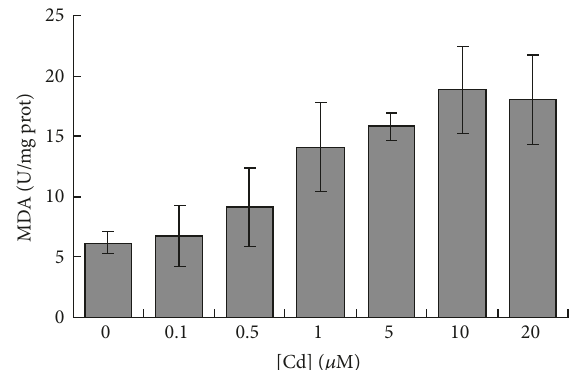
Figure 7: Relation of lipid peroxidation (expressed as amount of MDA) to solutions of various Cd